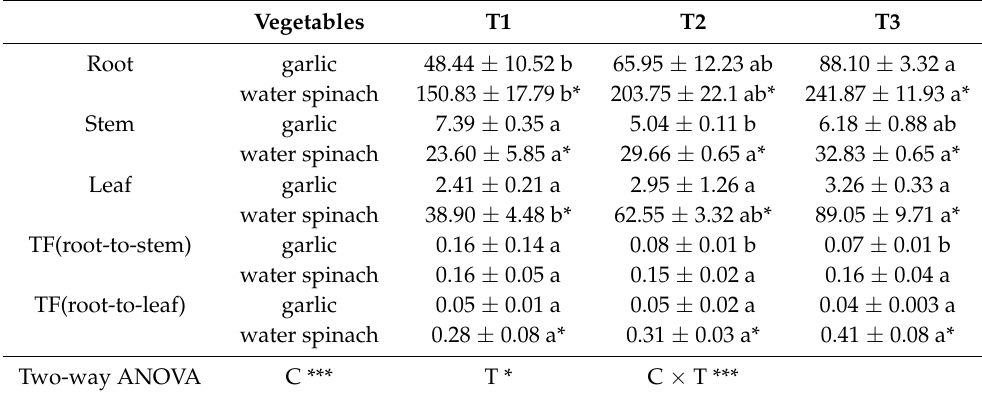
Figure 7. Garlic (with weak Cd accumulation capacity) and water spinach (with strong Cd accumulation capacity) were planted based on contrasting 10 mg Cd kg − 1 concentrations in their tissues and harvested at three time points (T1-10 days, T2-20 days, T3-30 days). Table 4. Cd concentrations in different tissues and transfer of Cd from root to stem/leaf in 10 mg Cd kg − 1 treatment at three time stages (T1-10 days, T2-20 days, T3-30 days) in garlic and water spinach ( n = 3, DW).